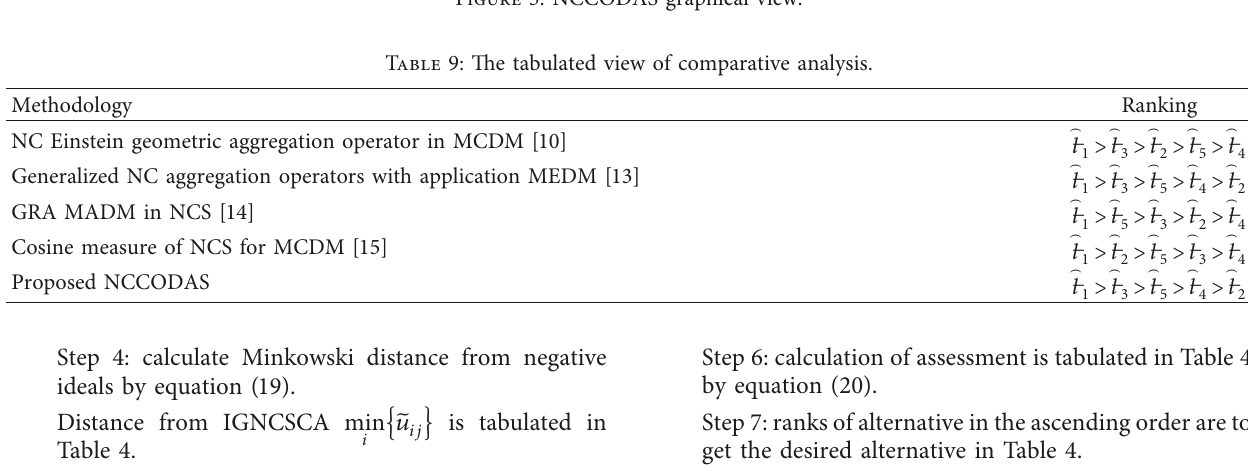
Table 4. Step 5: construction of relative assistance matrix with the help of equation (23) is tabulated in Table 4.